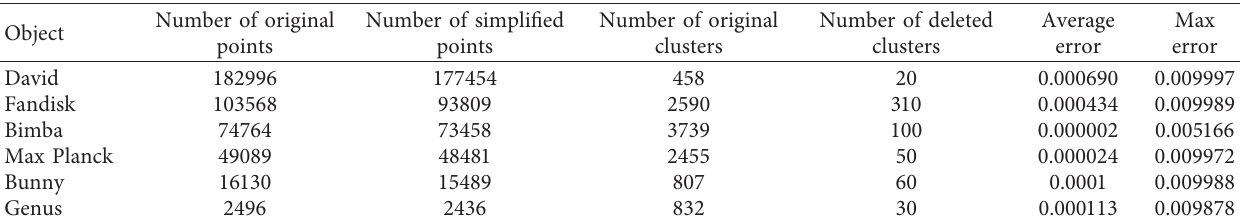
Figure 9: Simplification error of the Fandisk point cloud: (a) original point set, (b) simplified point set, (c) difference between original and simplified point cloud. Table 1: Statistics of the new simplification technique applied to different 3D point